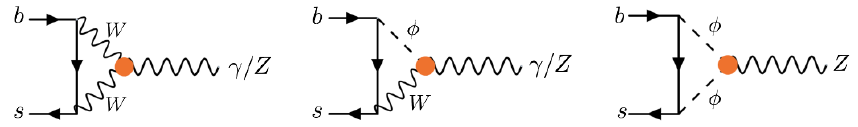
Figure 8 . Diagrams generating contributions to b ! sl + l (cid:0) and/or b ! s(cid:13) from Q W ((cid:12)rst diagram only), Q HD (second and third diagrams only), and Q HWB (all three diagrams). Since the operators Q HD and Q HWB a(cid:11)ect the Z mass, and Q HWB a(cid:11)ects the Z and photon couplings by